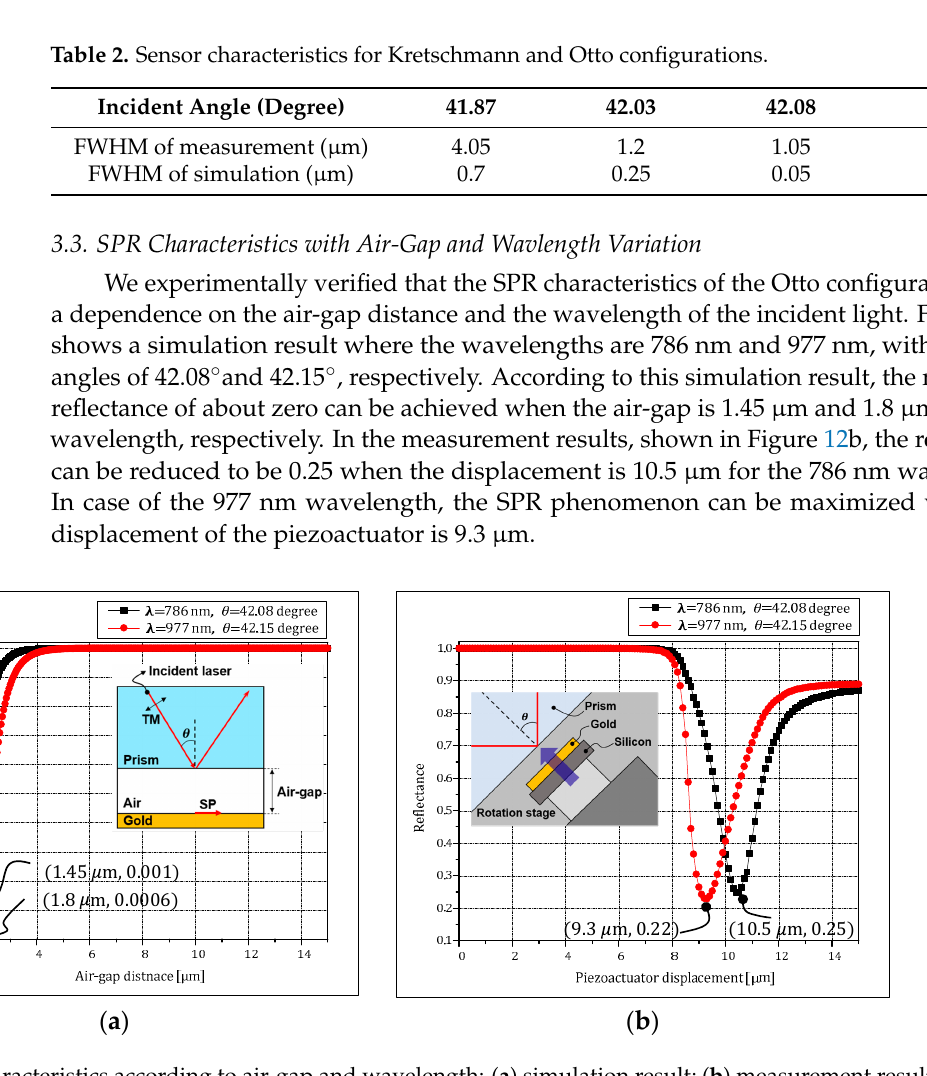
Figure 12. SPR characteristics according to air-gap and wavelength: ( a ) simulation result; ( b ) measurement result.